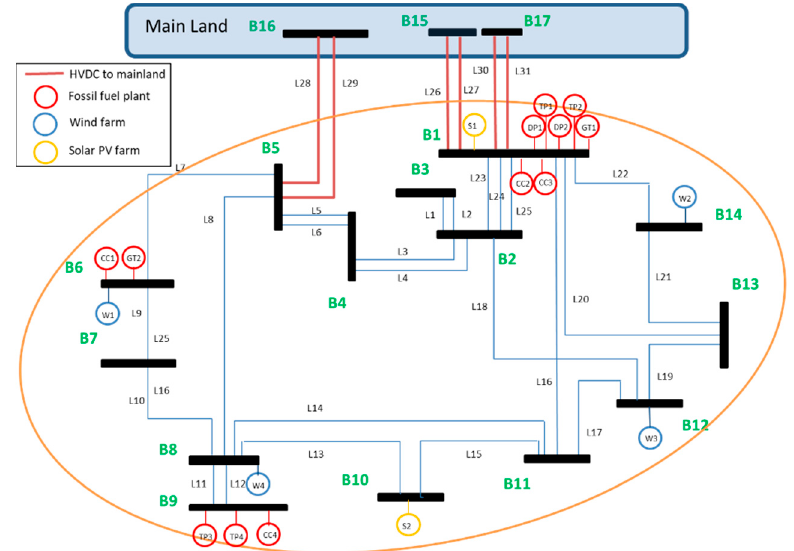
Figure 1. Power system network in Jeju Island (17-bus system).